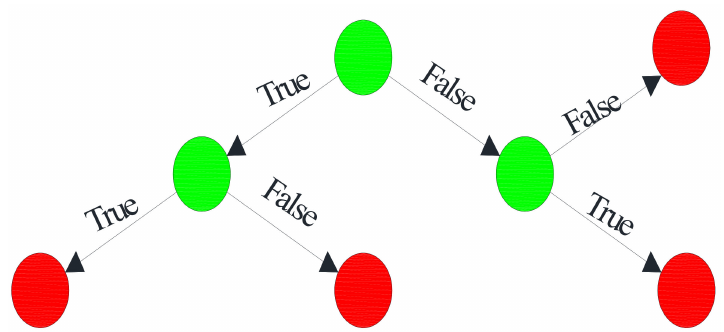
Figure 3. Decision